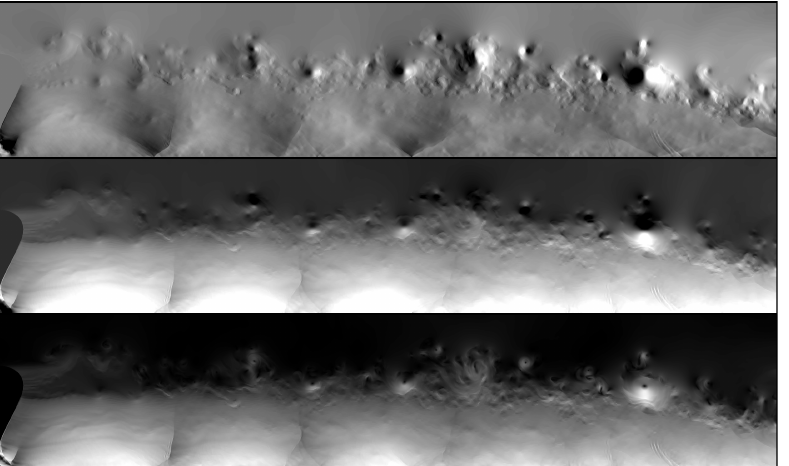
Figure 5. Cross section snapshot of the velocities in the simulation of Figure 4. The bottom of each panel is the symmetry axis, the ring plane is on the left, and the average direction of the flow is from left to right. ( Top )—radial velocity, ( Middle )—axial velocity, ( Bottom )—total speed. ( Top ): the white shading indicates that the flow is radially outward, whereas the black means that the flow is inward, showing an irregular vortex street. ( Middle ): lighter colours mean higher velocity away from the evaporating ring, whereas darker colours indicate velocity in the opposite